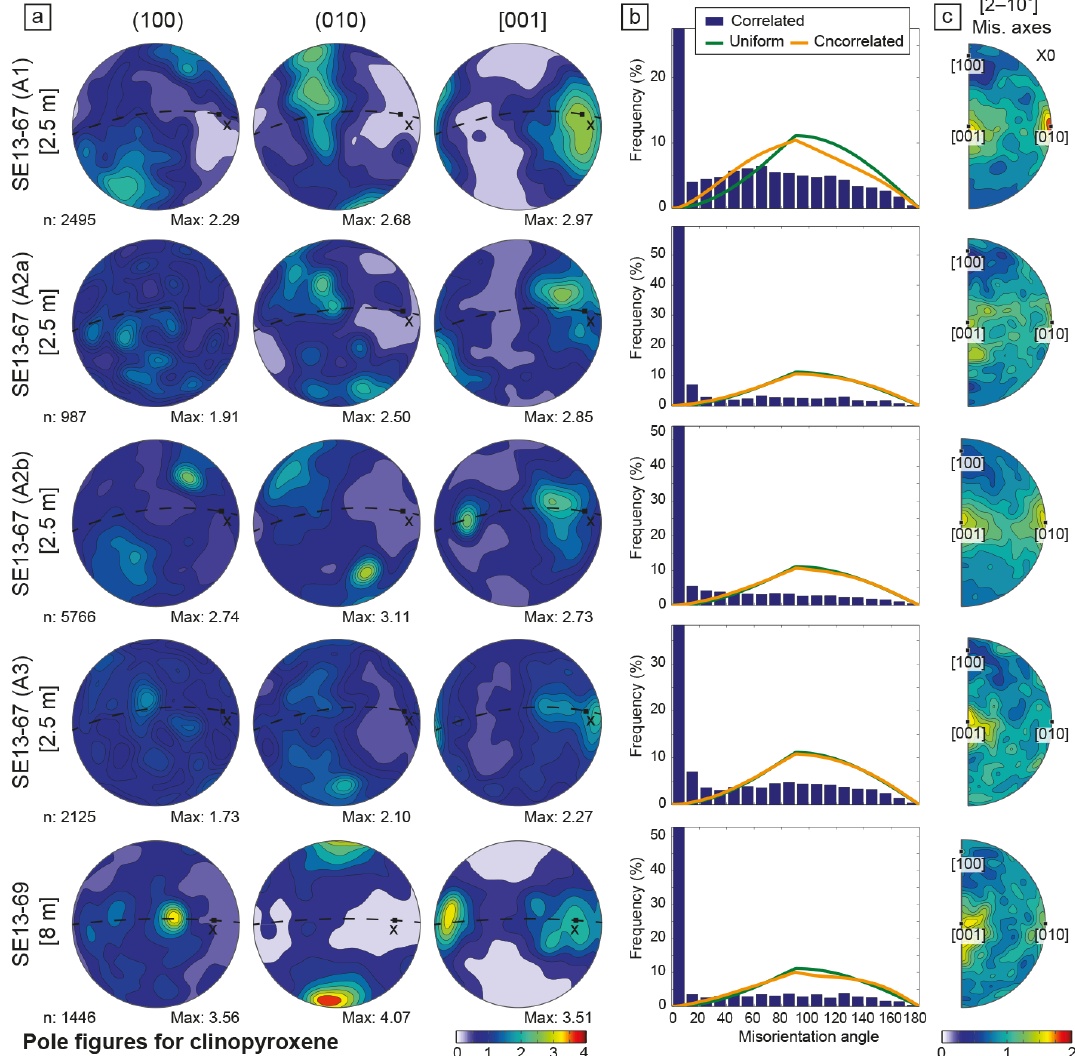
Figure 11. (a) Pole figures illustrating CPO of clinopyroxene in samples from the HTa unit of Sumeini; (b) distribution of misorientation angles; (c) inverse pole figures showing the distribution of correlated misorientation axes (between 2 and 10 ◦ ). See caption of Fig. 7 for